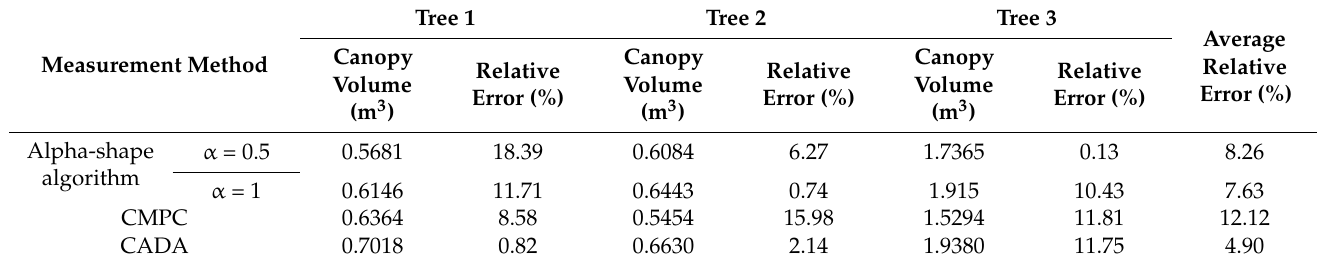
Table 7. Comparison of the measurement errors of different canopy volume detection methods.